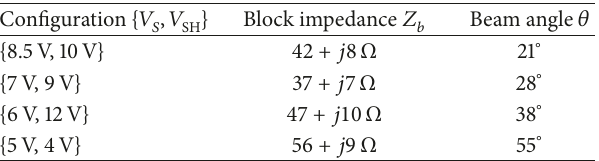
Table 1: Summary of four different configurations at the frequency of 2.46